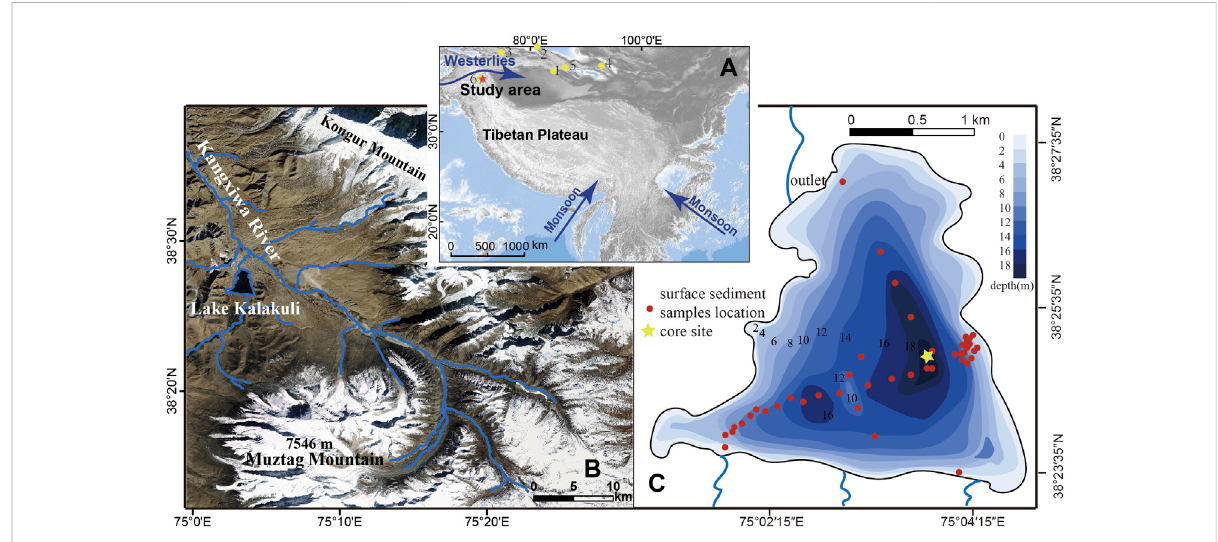
FIGURE 1 Maps of the study area. Map (A) shows the regional atmospheric circulation systems and the location of Lake Kalakuli (red star) in the Pamir Mountains. Theyellowdotsrepresentthemainpaleoclimaticrecordsmentionedinthediscussion(1.BostenLake;2.AibiLake;3.Issyk-Kul; 4.Barkol Lake; 5. Chaiwopu Lake; 6. Sate Baile Dikuli Lake). Map (B) shows Lake Kalakuli within its hydrological settings and the position of the Muztag Ata glacier.Map (C) showsthebathymetryofLakeKalakuliwiththelocations ofthesamplingsiteforthemastercore(yellowstar)andofthesurface sediment samples (red dots) used to develop the diatom-based water depth transfer